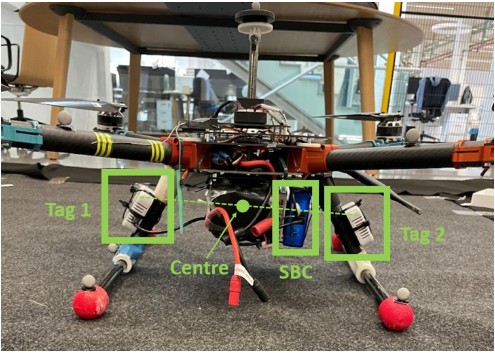
Figure 3. Tags on the